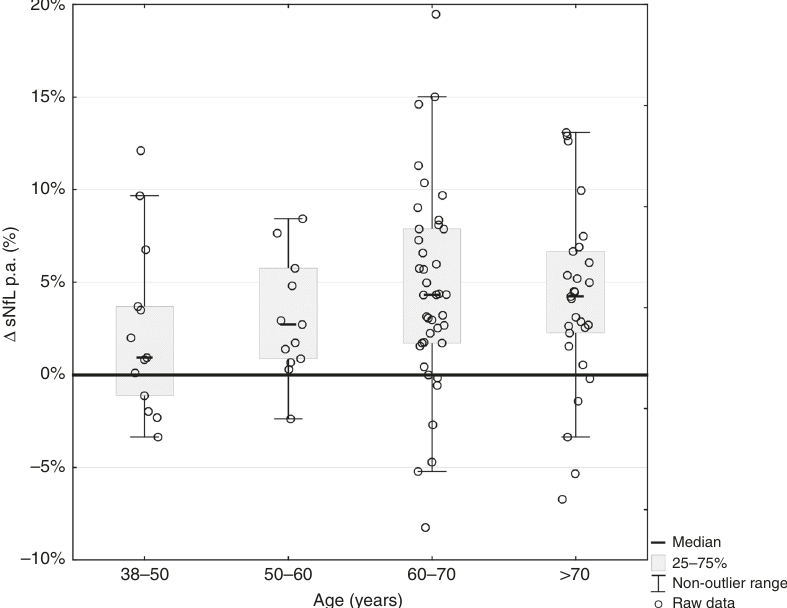
Fig. 4 Annualized increase of sNfL per age groups. Annualized increase of sNfL in different age groups. Bars represent median values of proportional annual change per age group. A substantial higher increase is seen in the age groups above 60 years. sNfL serum neuro fi lament light, p.a. per annum. Source data are provided as a Source Data fi